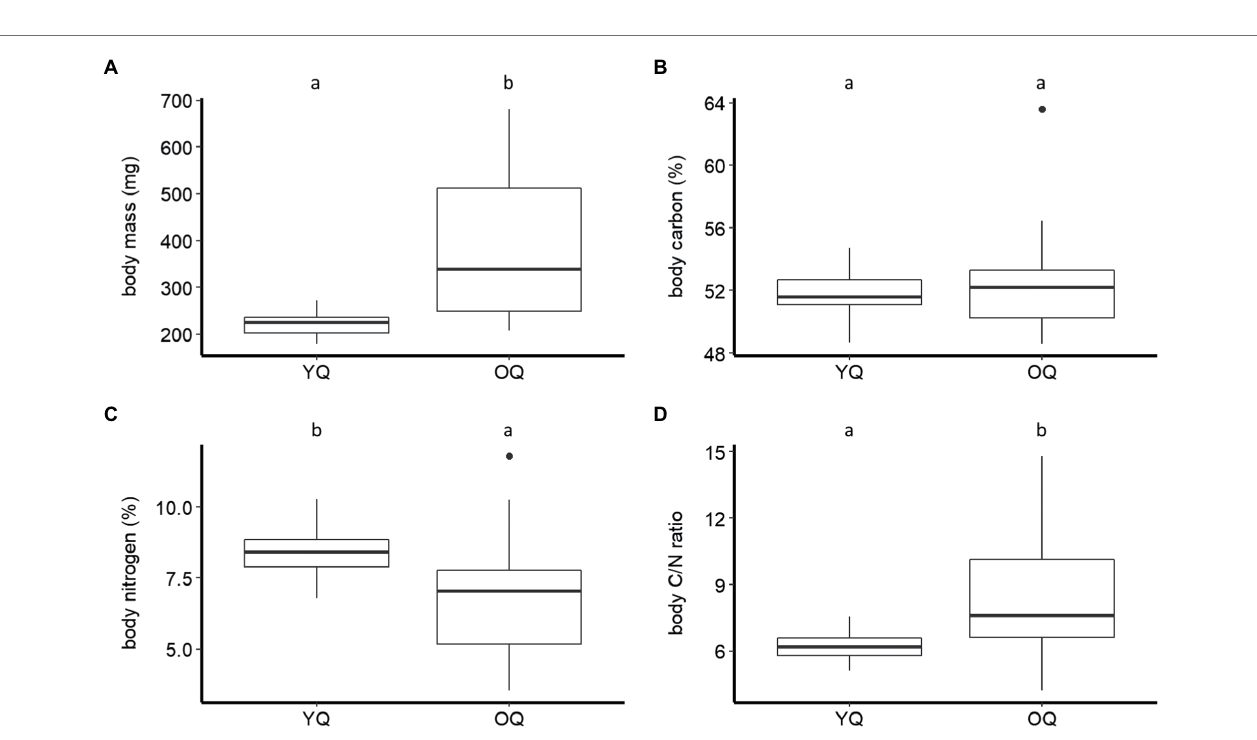
FIGURE 1 | Boxplots of dry body mass (A) , carbon, (B) nitrogen percentage (C) , and carbon-to-nitrogen ratio (D) of males (M), queens (Q), and workers (W) of B. terrestris . Significantly different means are denoted above each panel by use of compact letter display.